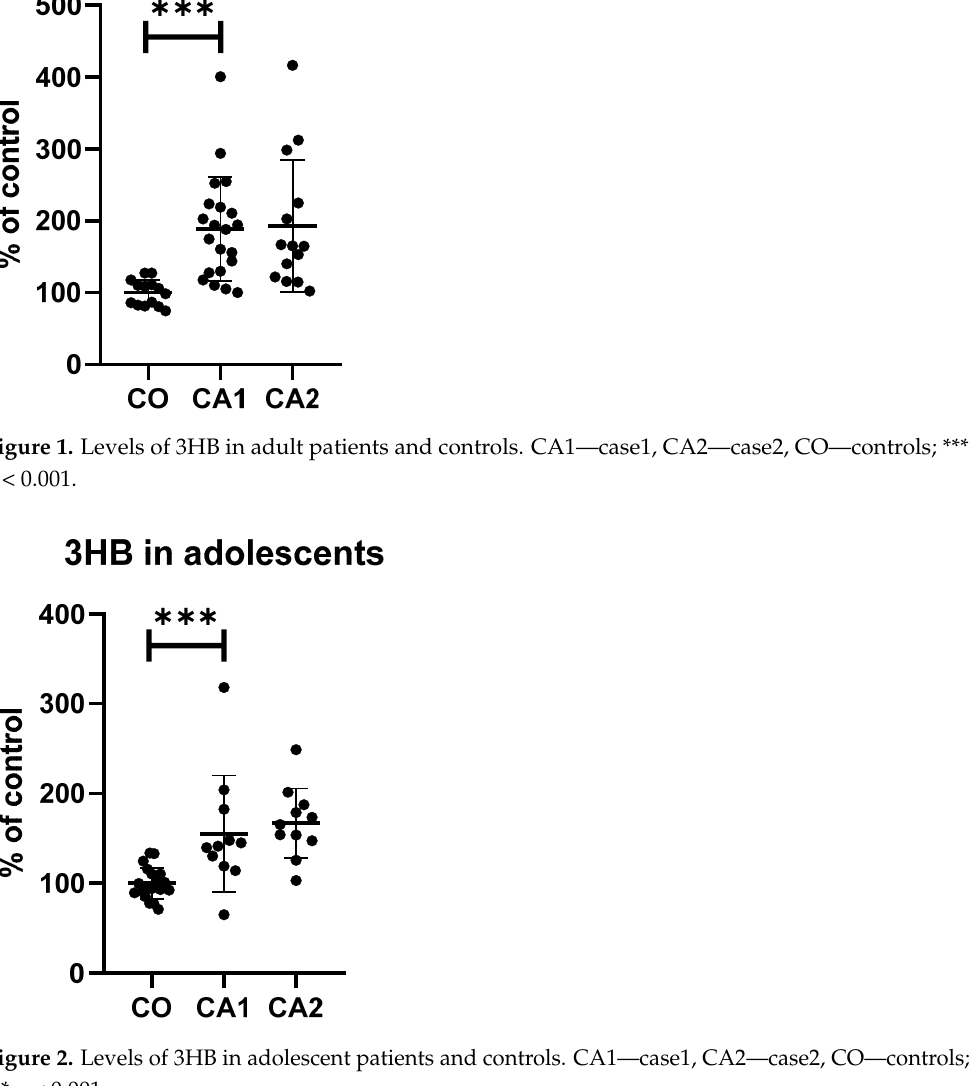
Figure 2. Levels of 3HB in adolescent patients and controls. CA1—case1, CA2—case2, CO—con ‐ trols; *** p < 0.001 .